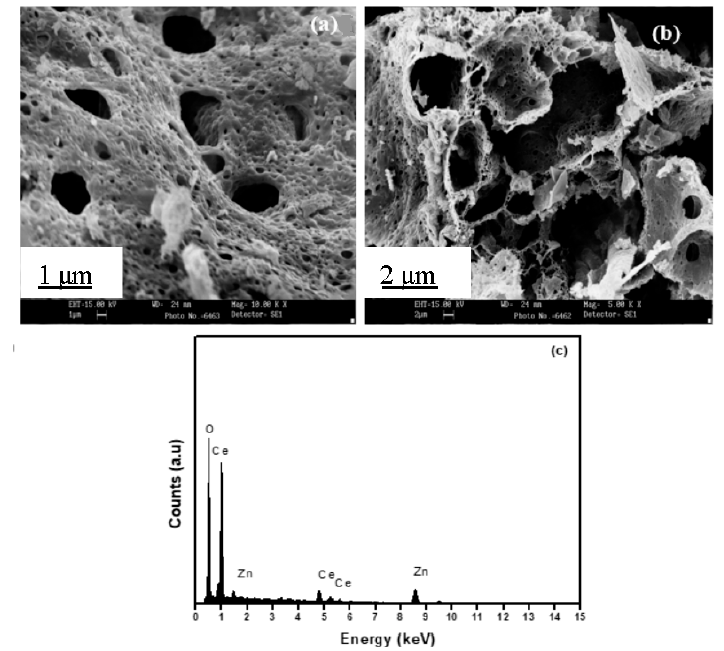
Figure 8. ( a , b ) SEM images and ( c ) EDS pattern of the CeO 2 -ZnO nanocomposite.